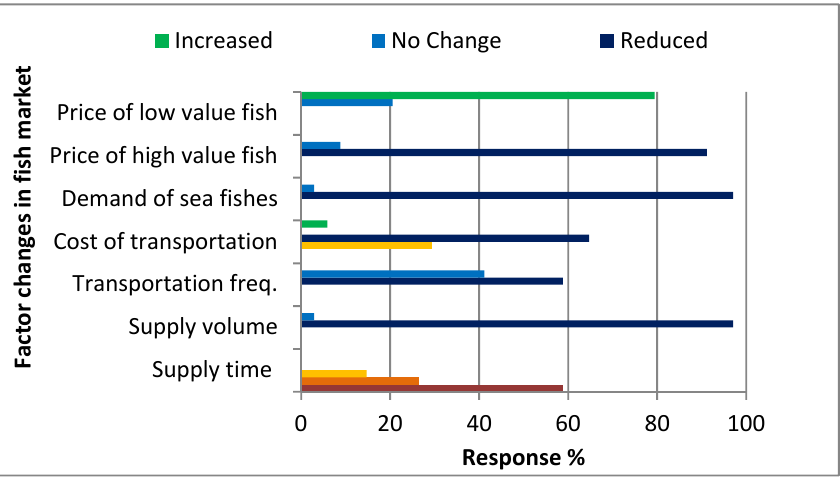
Figure 2 . Perception of impacts of COVID-19 on supply chain of fish markets . Figure 2. Perception of impacts of COVID-19 on supply chain of fish